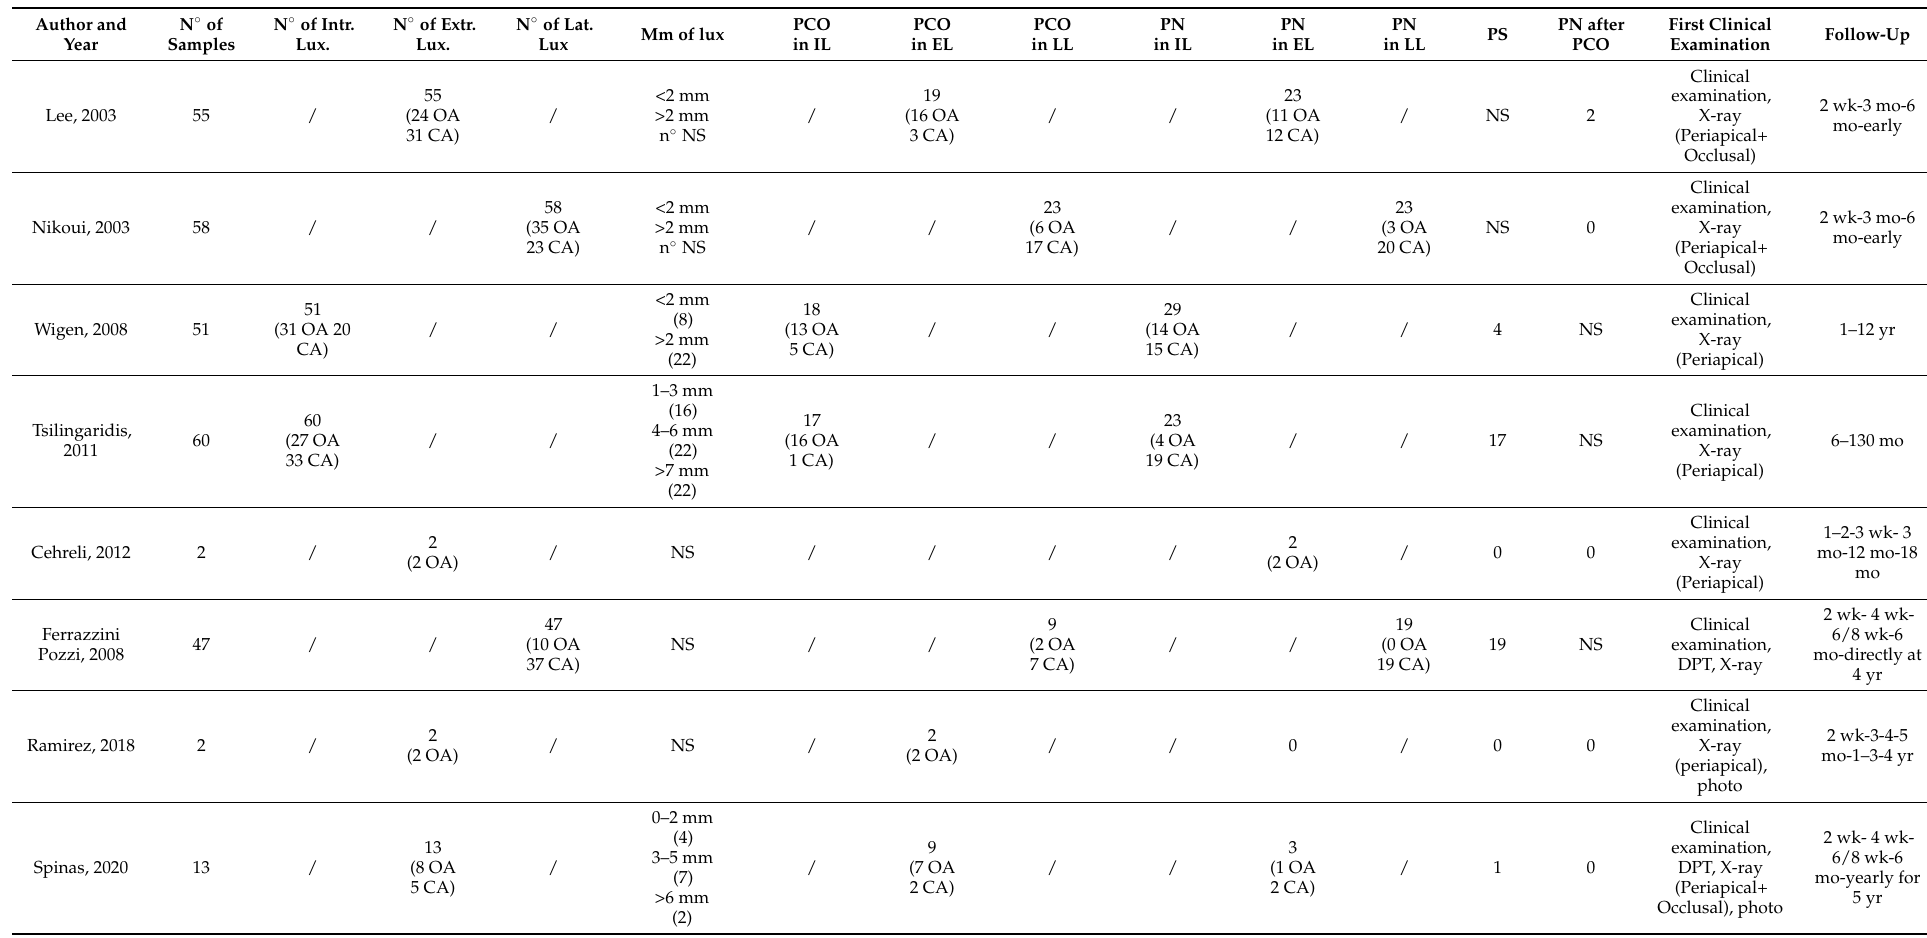
Table 1. The table shows data from the included studies, summarizing diagnostic and clinical